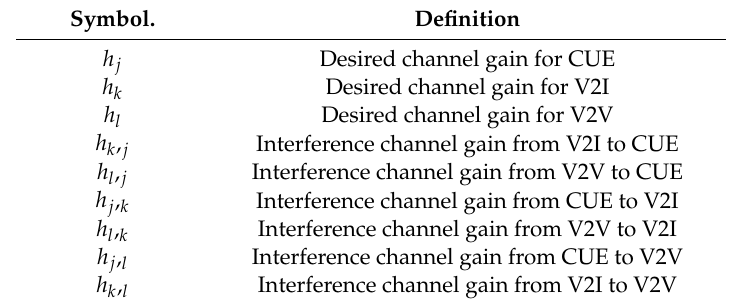
Table 2. Di ff erent channel gains.